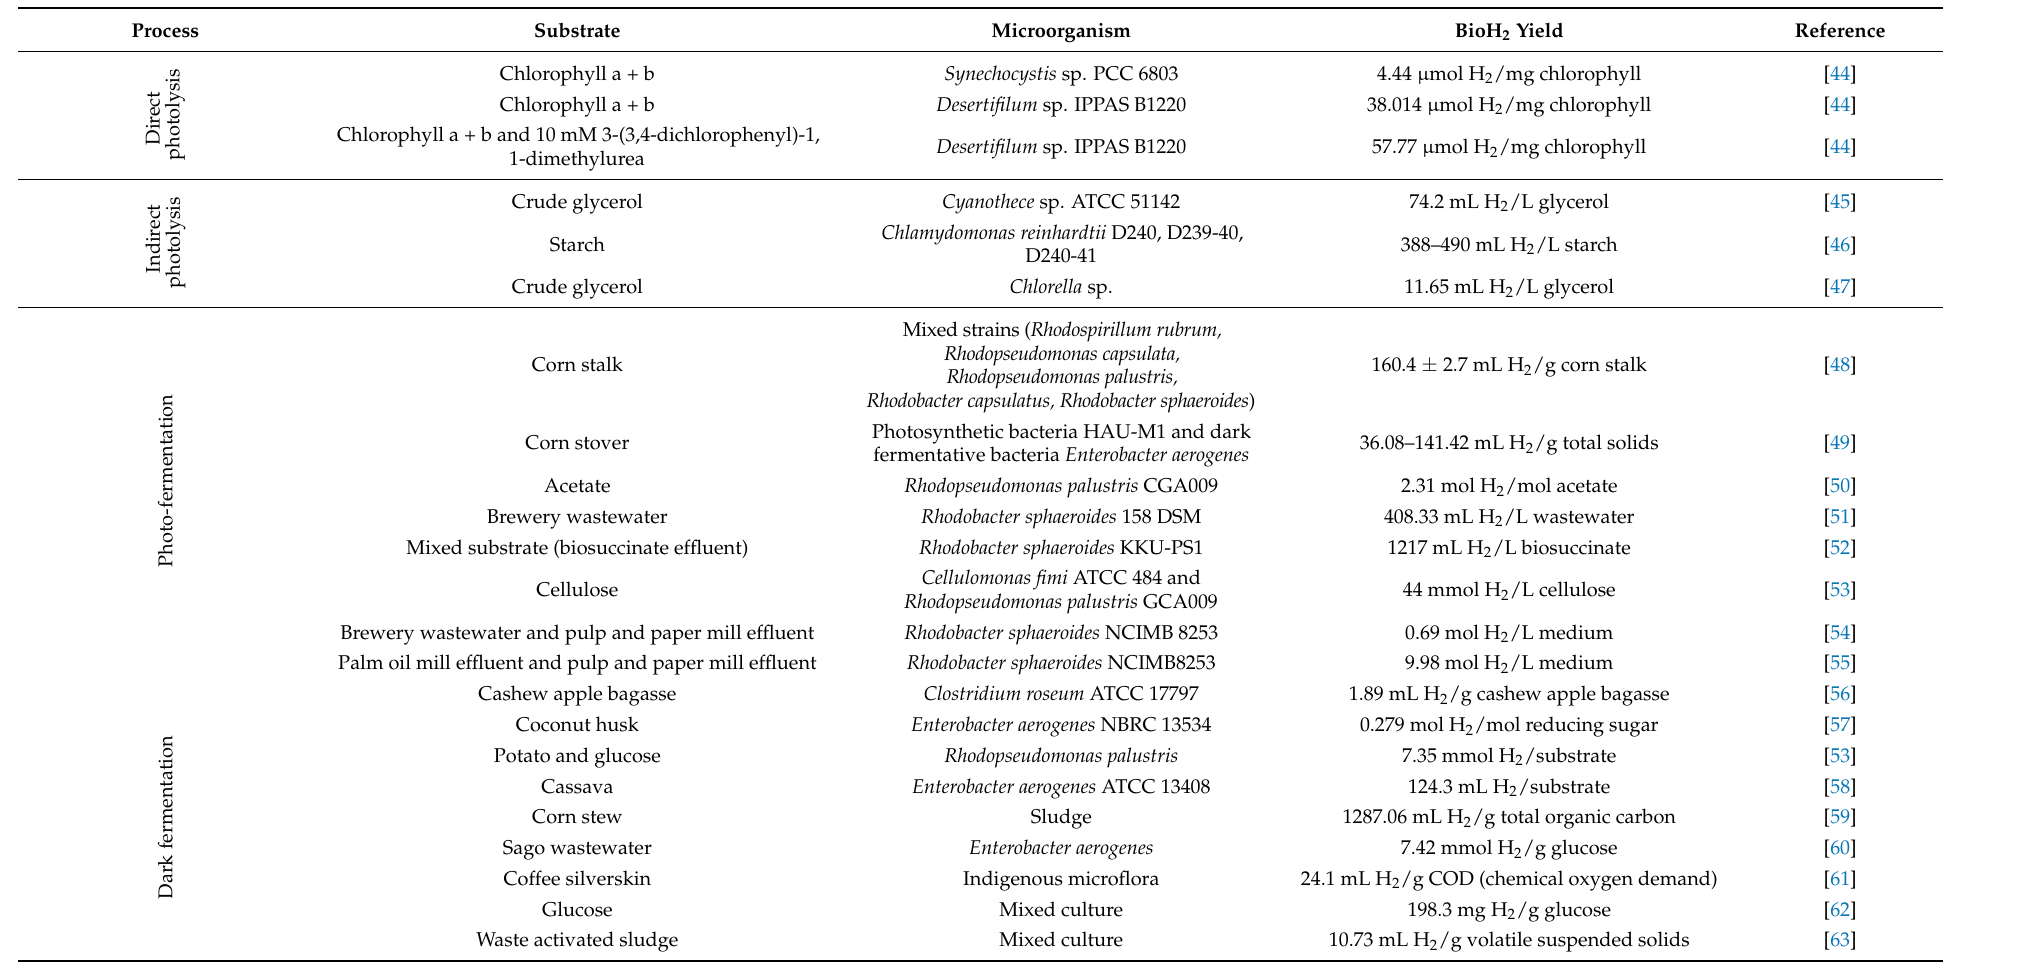
Table 3. Overview of BioH 2 production